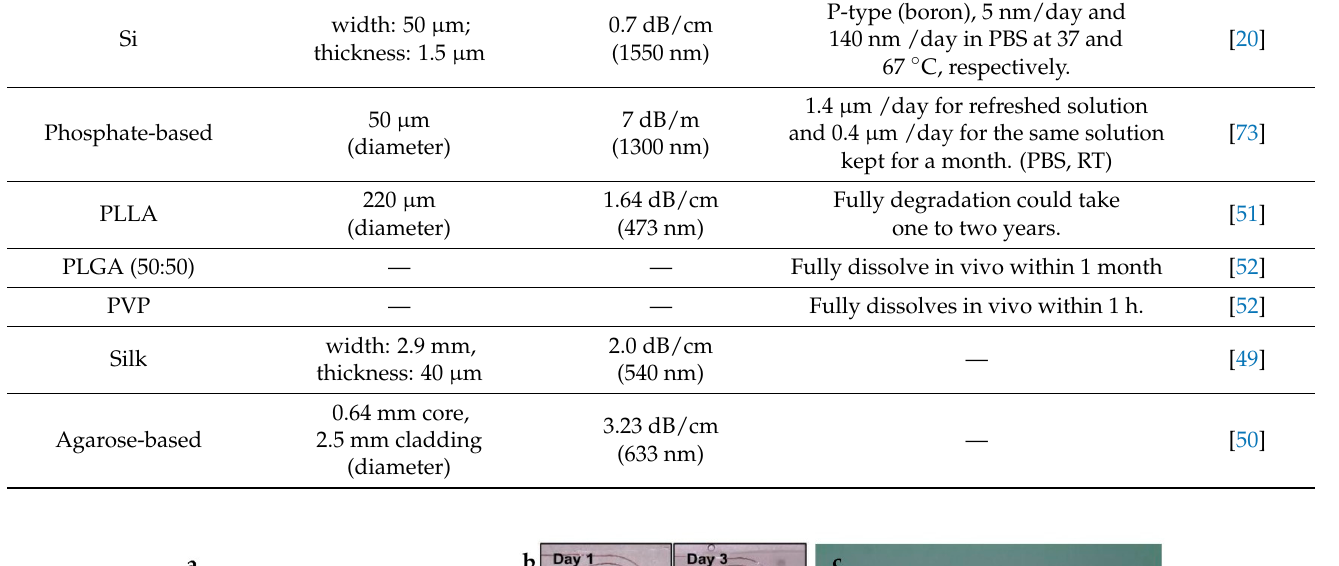
Table 2. Optical loss and degradation rate of common biodegradable optical waveguides. Materials